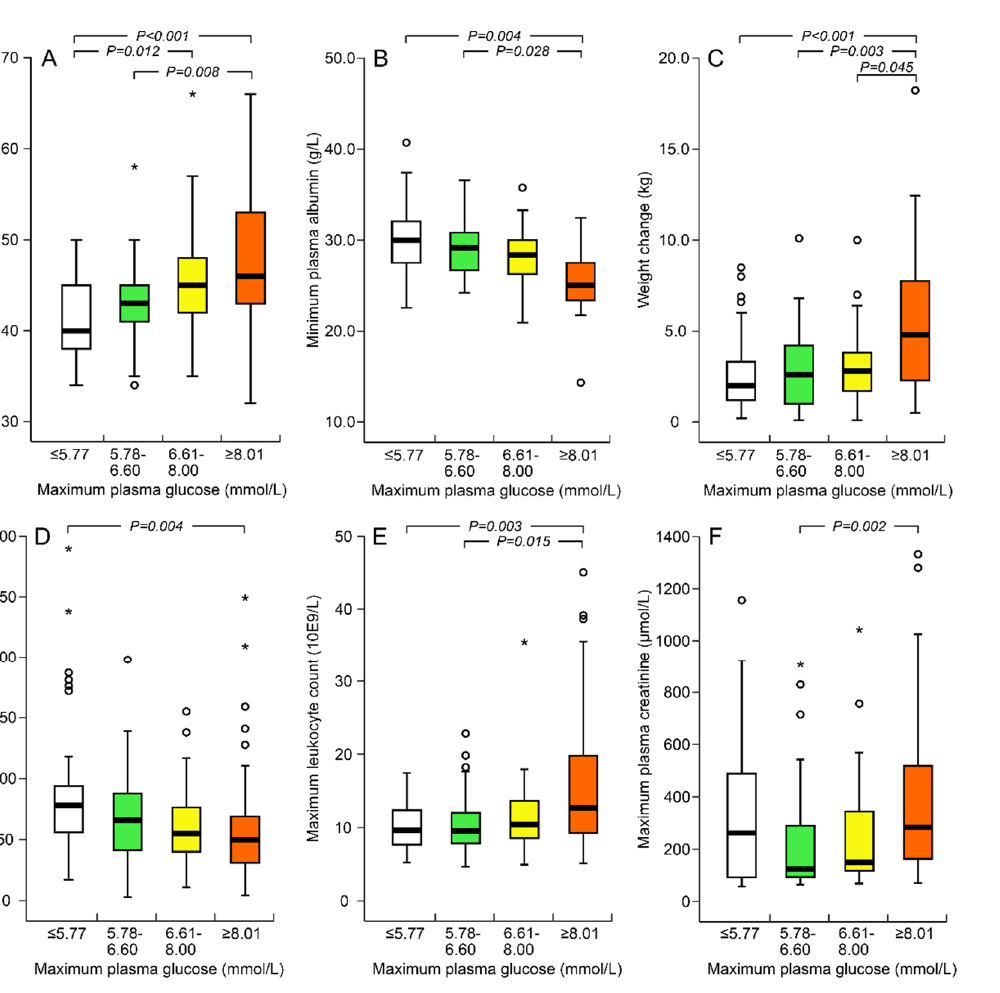
Figure 1. Maximum hematocrit ( A ), minimum plasma albumin (g/L) ( B ), weight change during hospital care (kg) ( C ), minimum platelet count ( × 10 9 /L) ( D ), maximum blood leukocytes ( × 10 9 /L) ( E ) and maximum plasma creatinine ( µ mol/L) ( F ) as grouped according to quartiles of maximum plasma glucose concentration. Boxplots with median, interquartile range, minimum and maximum within 1.5 interquartile range, and outliers displayed as circles and extreme values as asterisks. Bonferroni correction for multiple comparisons was applied in the post-hoc